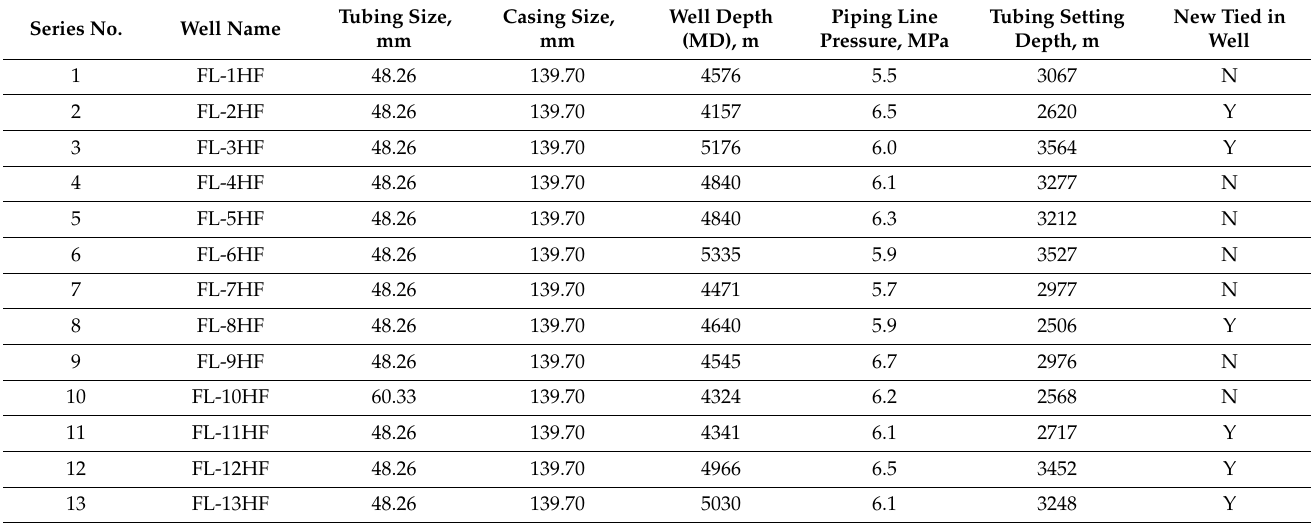
Table 2. Well candidates for low pressure gas lift operation.